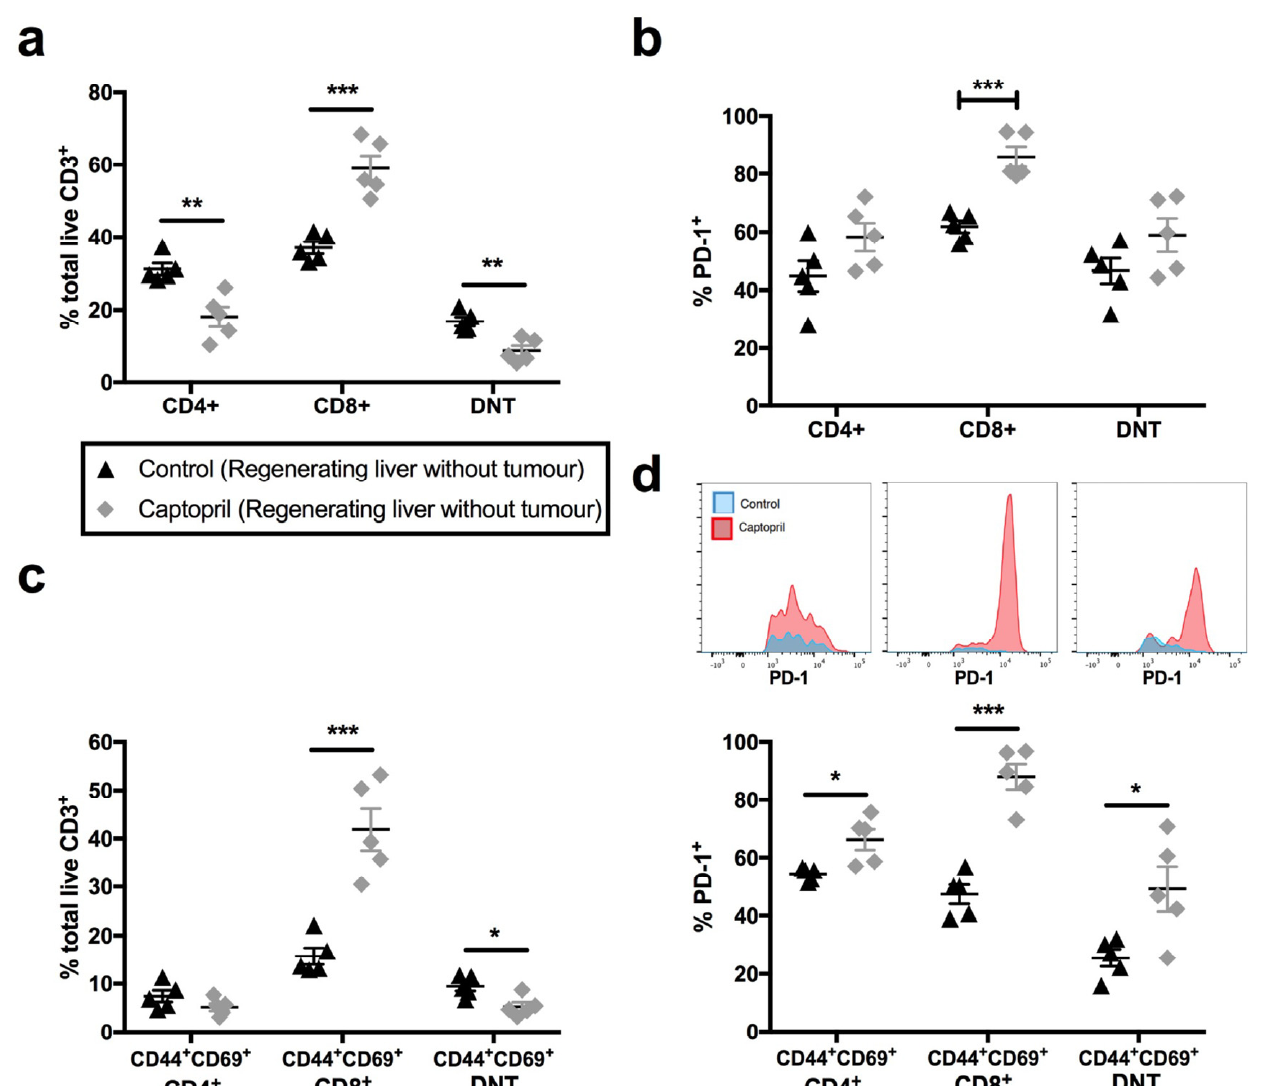
Figure 4. Captopril modulates T-lymphocyte populations in the regenerating liver, in the absence of tumour. Mice commenced treatment with either saline (control) or captopril 250 mg/kg/day and did not undergo tumour induction. Briefly, 70% hepatectomy was performed 3 days after the com- mencement of treatment, and mice were culled nine days following partial hepatectomy in keeping with prior experiments. Liver specimens were retrieved for flow cytometry: ( a ) proportion of total CD3 + T lymphocytes that were CD4 + , CD8 + and DN T (CD4 - /CD8 - ); ( b ) percentage of PD-1 + T lym- phocyte subpopulations; ( c ) proportion of CD4 + , CD8 + and DN T lymphocytes co-expressing T RM markers, CD44 + and CD69 + ; ( d ) percentage of PD-1 + T RM -like T lymphocyte populations and insets of concatenated histograms demonstrating fluorescence intensity of PD-1 on T RM -like populations. Data are representative of a single experiment (control, n = 5 mice, captopril, n = 5 mice). Significant differences were determined by an unpaired, two-tailed Student’s t -test. p < 0.05 (*), p < 0.01 (**), p < 0.001 (***).